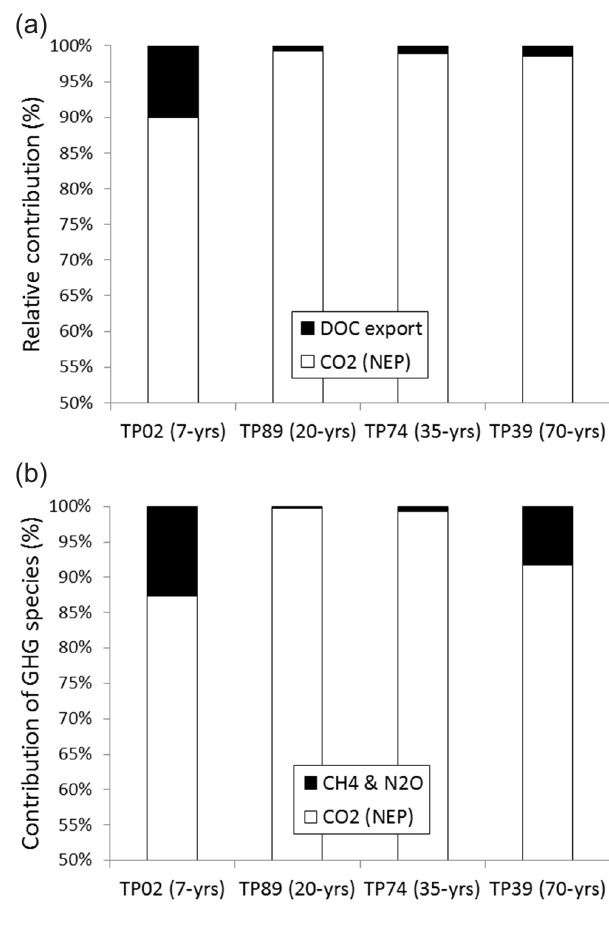
Figure 4. (a) Relative contributions of the DOC export (below 1m depth) and NEP to the total C balance and (b) relative contribution of the CO 2 exchange and the combined CH 4 and N 2 O exchange to the GHG balance at the four Turkey Point pine forest sites: TP02, TP74, TP89 and TP39.